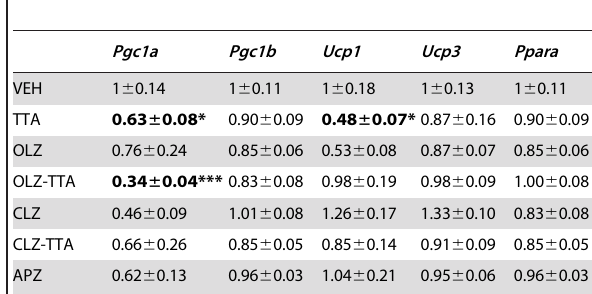
Table 6. Relevant genes examined in brown adipose tissue (BAT) in the subchronic study.